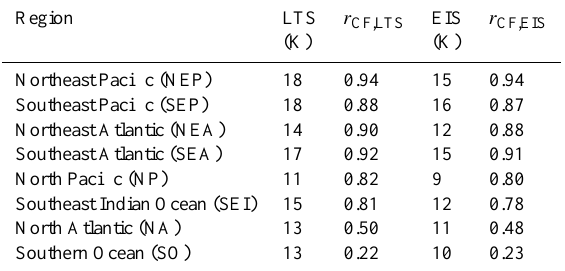
Table 3. Annual means of lower tropospheric stability (LTS) and estimated inversion strength (EIS) as well as the correlation coef- ficients between low-cloud fraction from CloudSat/CALIPSO and LTS ( r CF,LTS ) and EIS ( r CF,EIS ). All values are derived from 5 years of data from the CloudSat ECMWF-AUX